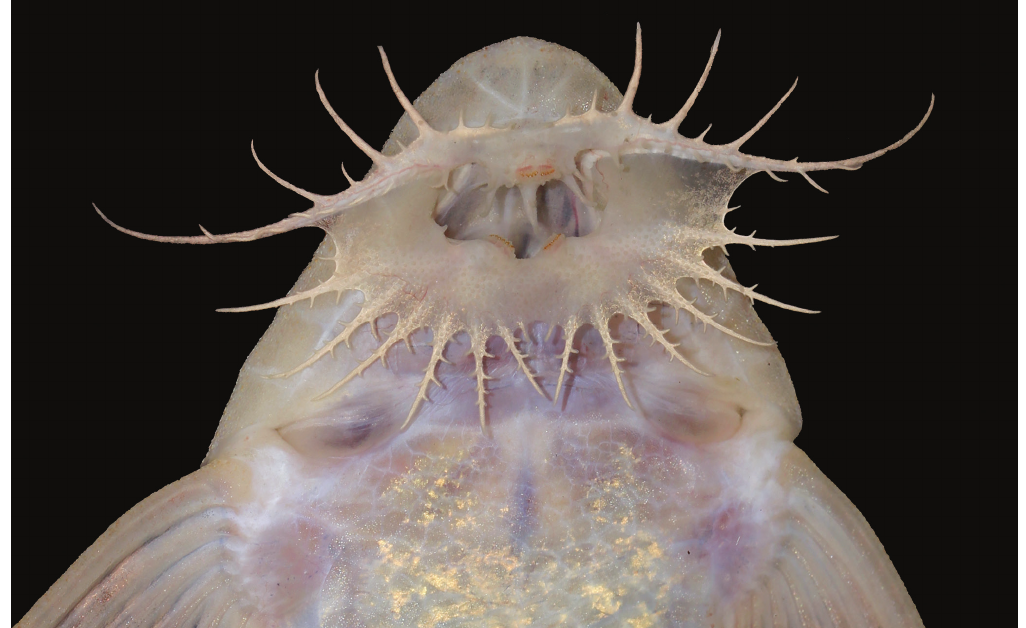
Fig. 2. Pseudohemiodon unillano , paratype, IAvH-P 19088, 183.2 mm SL. Detail of mouth in live specimen. Photograph by A. Ortega-Lara .